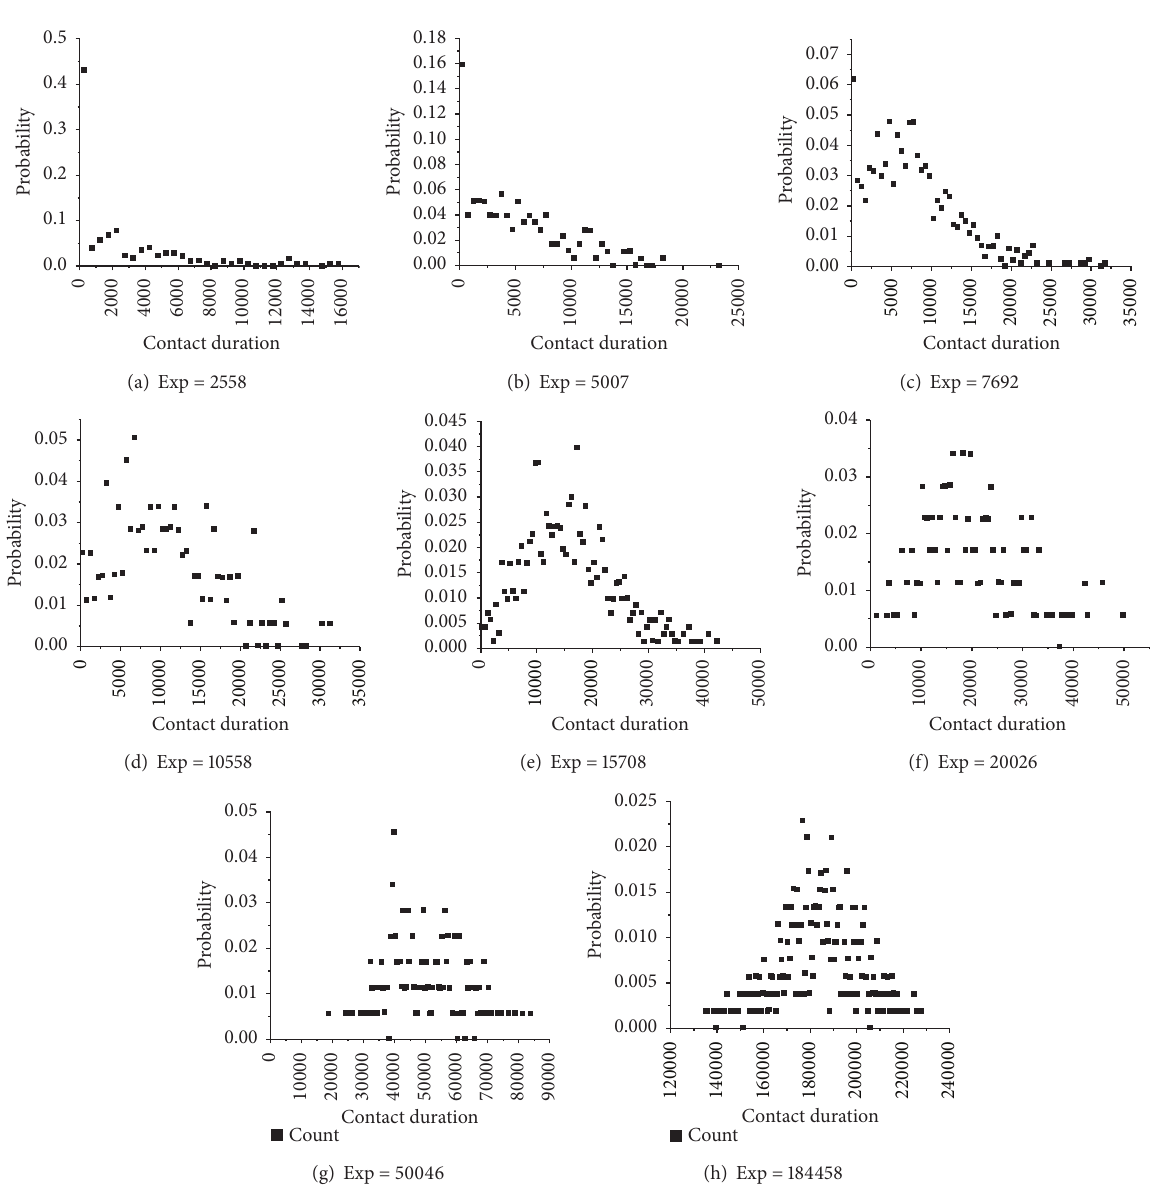
Figure 4: Distributions of contact durations under different expected